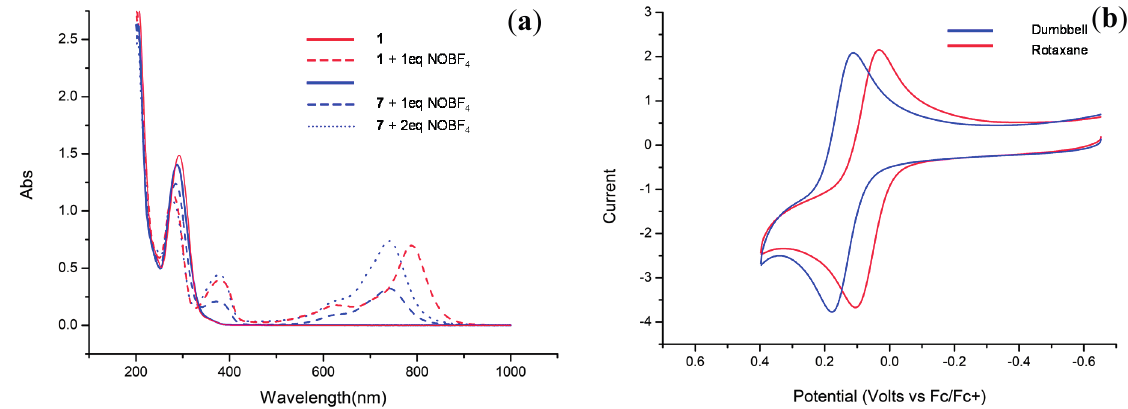
NOBF 4 ; ( b ) Cyclic voltammograms of the [2]rotaxane 1 (0.5 mM) and the dumbbell-shaped molecule 7 (0.5 mM) in CH 3 CN; supporting electrolyte: NBu 4 PF 6 (0.1 M); scan rate: 100 mV · s − 1